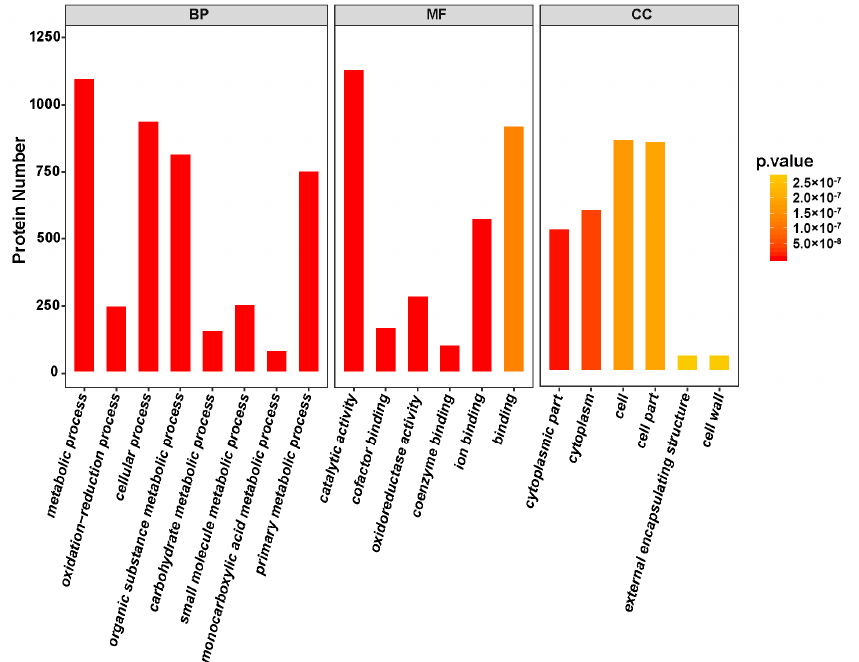
Figure 7. Gene Ontology (GO) enrichment analysis of the identified proteins.